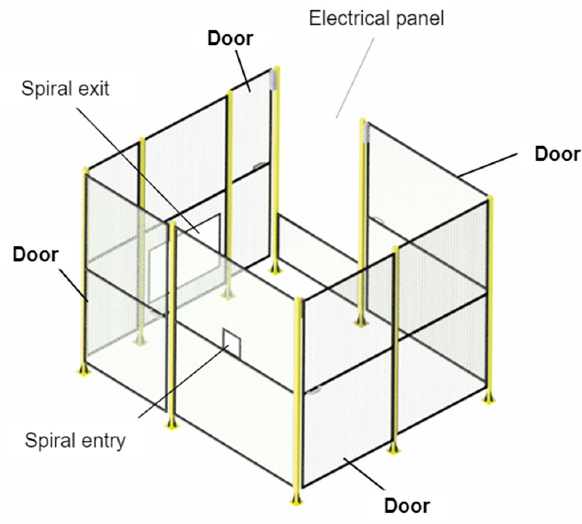
Figure 22. Safety barrier for the machine.